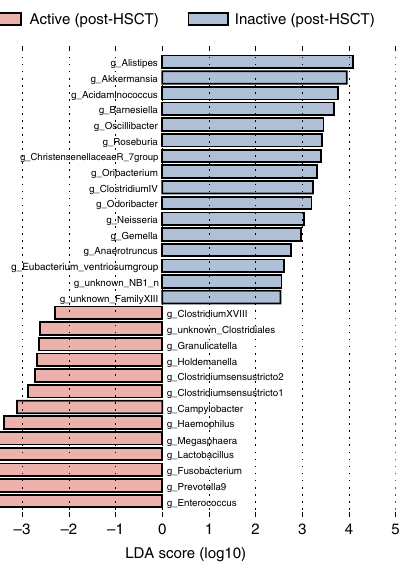
at baseline and at week 26 post-HSCT, the primary endpoint for the assessment of HSCT responsiveness (Supplementary Fig.